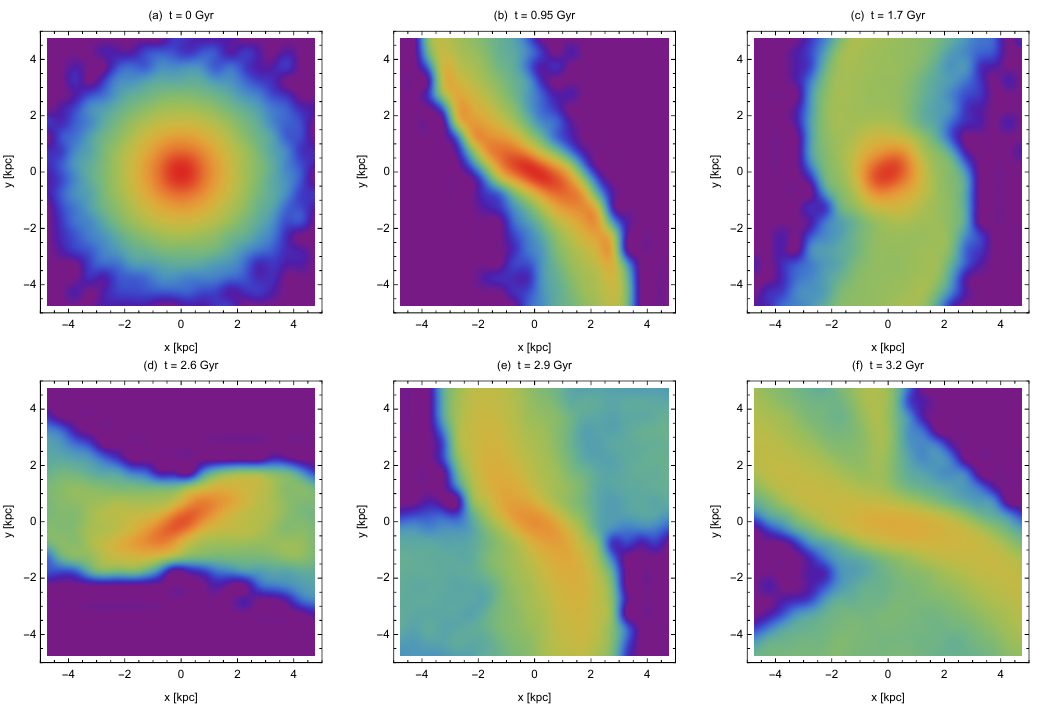
Figure 2. Surface density distribution of the stars of the dwarf at different times in projection onto the orbital plane. The logarithmic color scale was normalized to the maximum surface density reached at t = 0.95 Gyr. Panels ( a – f ) illustrate the shape of the dwarf at different stages of evolution with times from the start of the simulation indicated at the top of each plot.